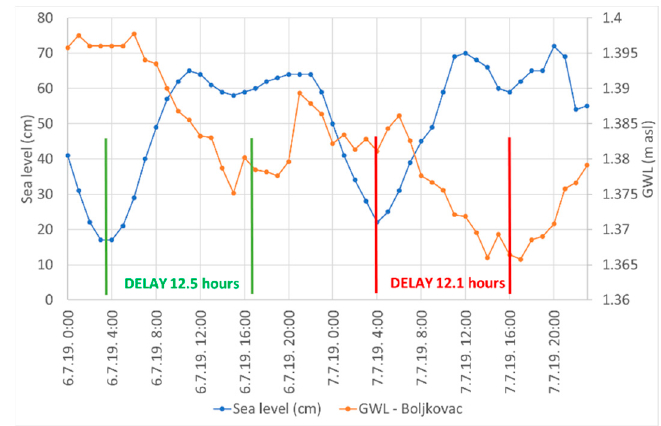
Figure 11. Influence of tides on the Boljkovac water supply facility.